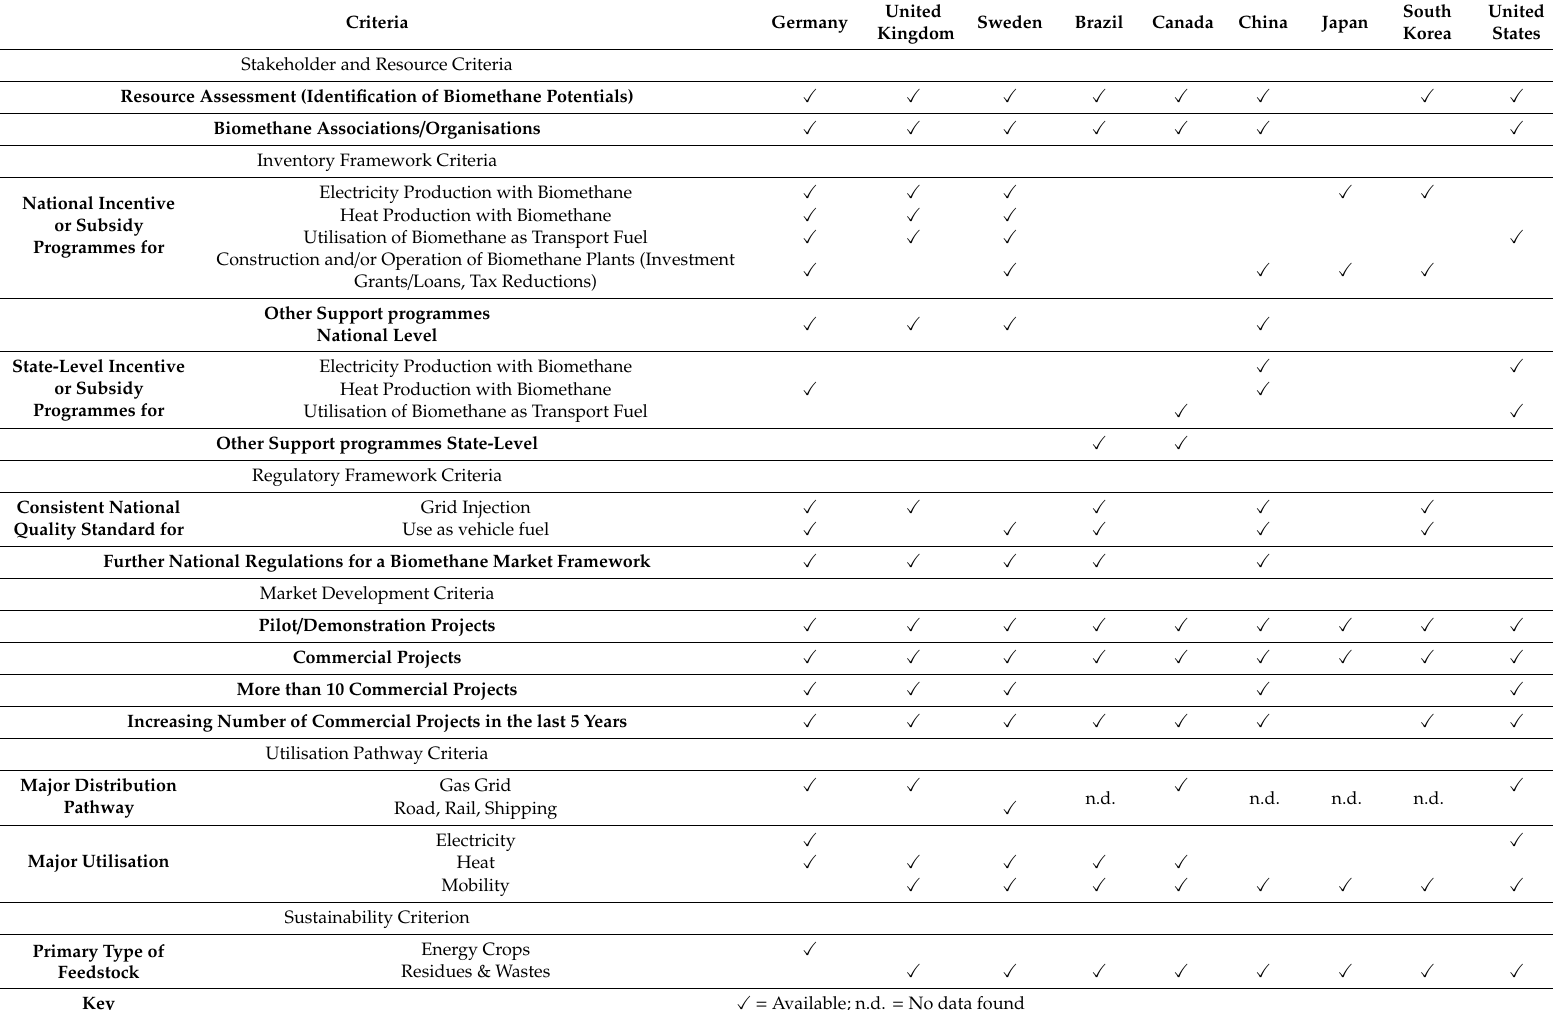
Table 3. Market comparison checklist